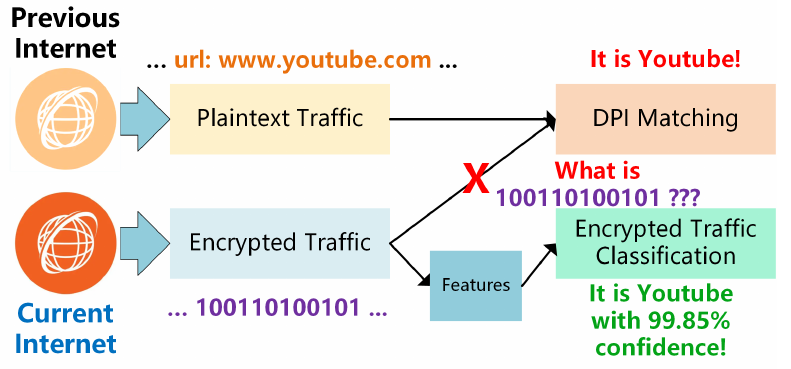
Figure 2. Problem of network traffic